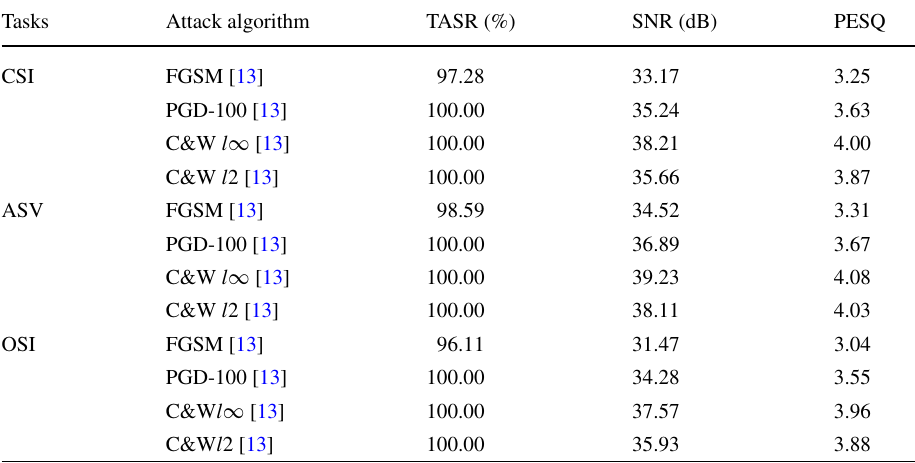
Table 10 Results of white-box attacks